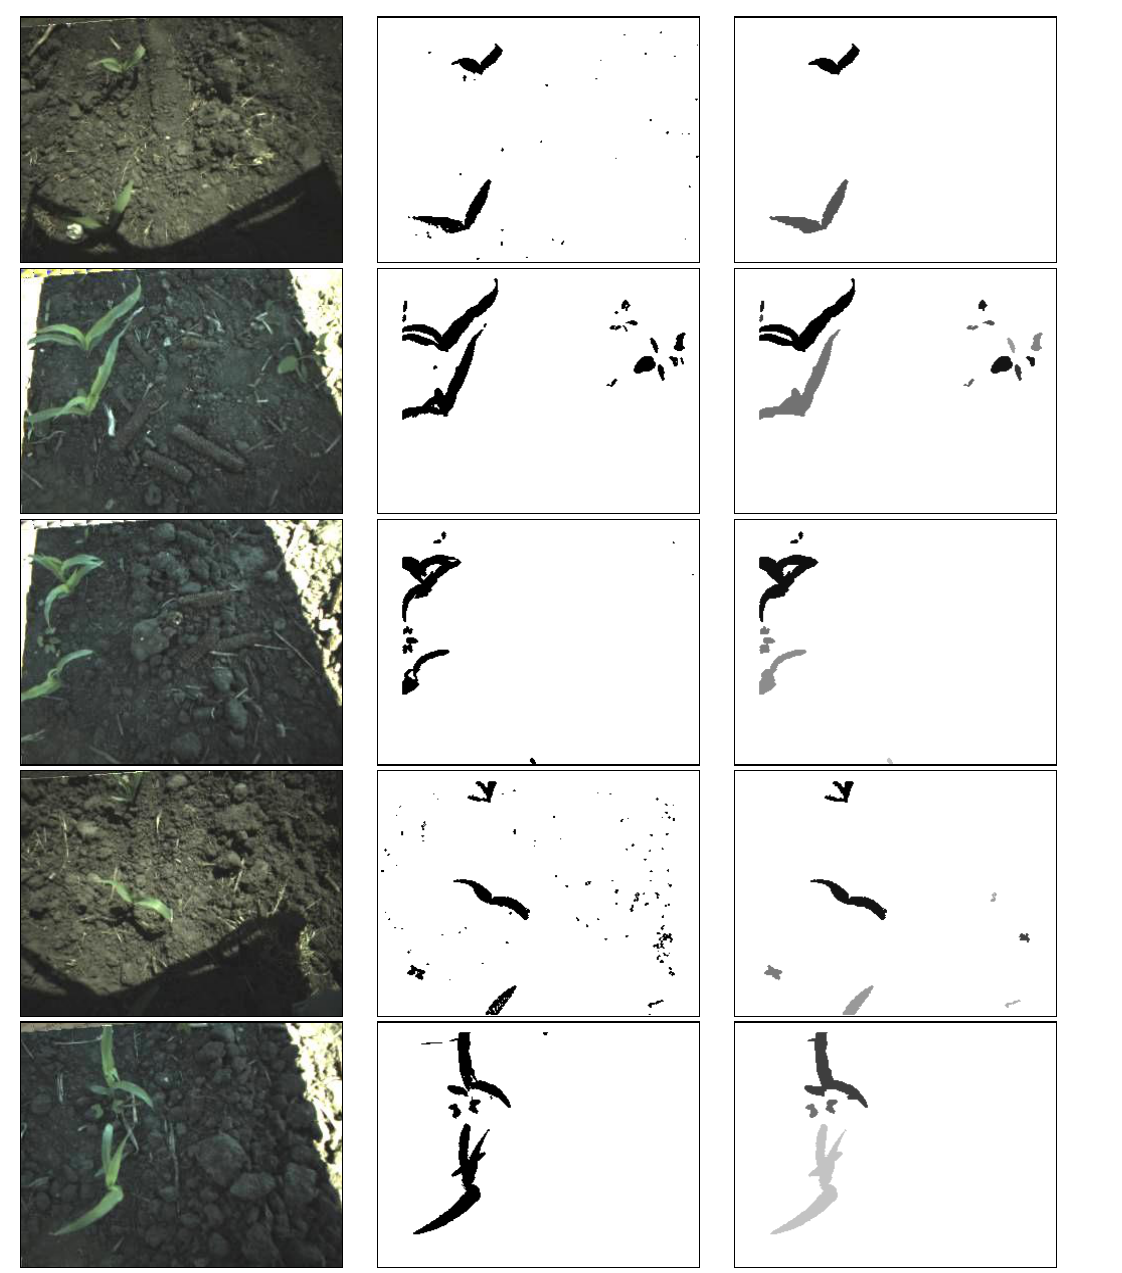
Figure 5. Example results of image processing: raw field image ( left column ), plant segmentation ( middle column ), and individual plant identification (different plants have different gray scale intensity, right column